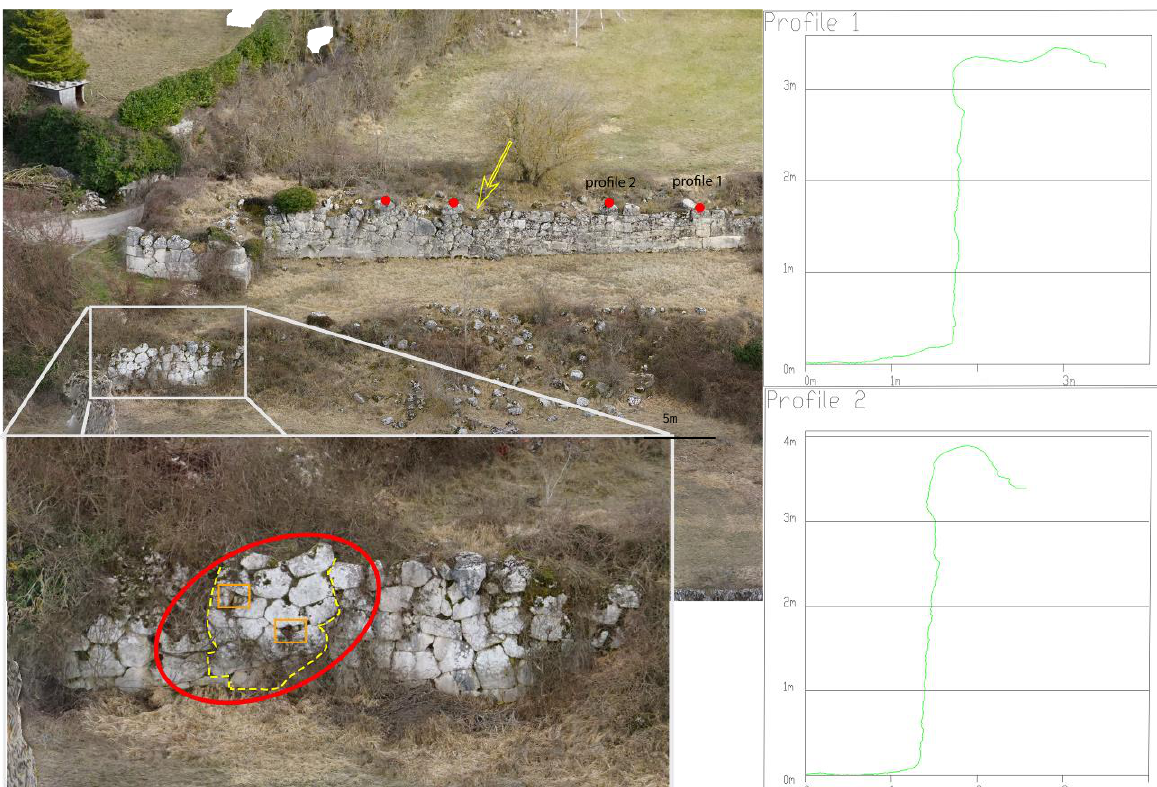
Figure 9. Degradation phenomena on the orthomosaic of the northern walls (left) and profile of the instability blocks of the walls